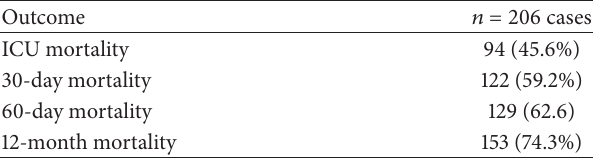
Table 3: ICU patient